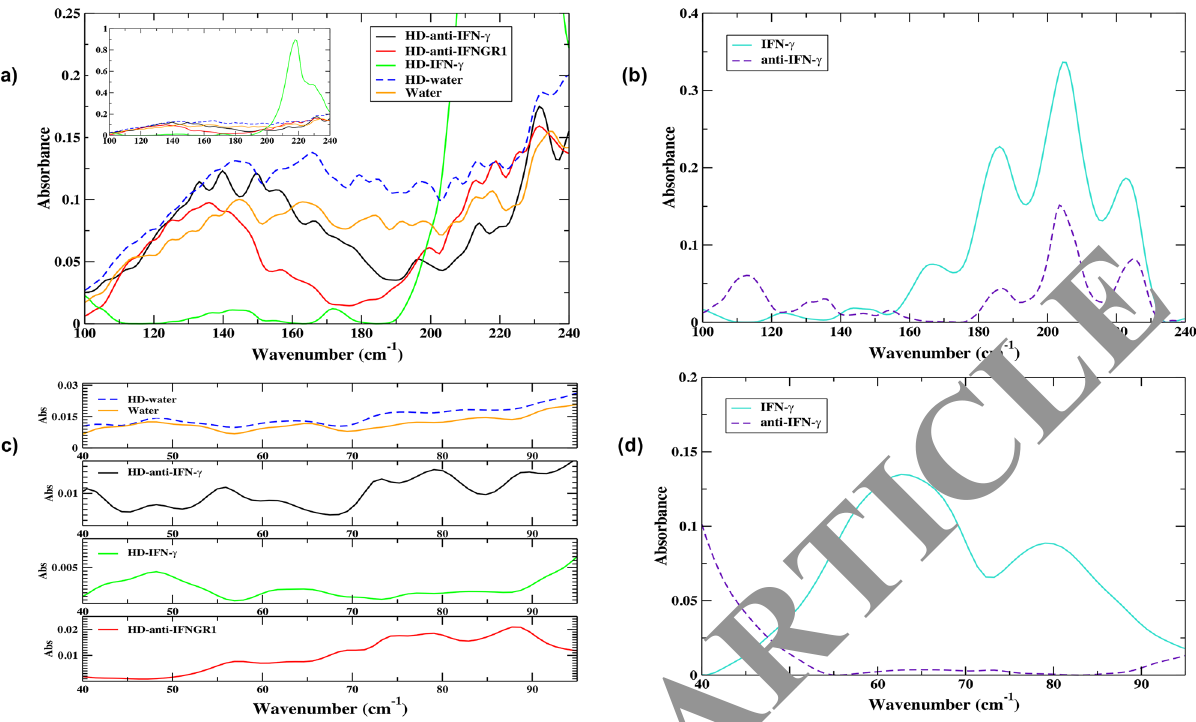
Figure 1. ( a ) Experimental THz spectrum of water (orange), HD-water (blue, dashed line), HD of antibody to IFN - γ (black), HD of antibody to IFNGR1 (red) and HD of IFN - γ (green) in the 100–240 cm − 1 spectral region. The inset shows the full amplitude of the HD-IFN - γ sample in the spectral region highlighting a prominent 217 cm − 1 mode in the spectrum. ( b ) Experimental THz spectrum of IFN - γ (cyan) and anti-IFN - γ (purple dashed line) in the 100–240 cm − 1 spectral region. ( c ) Experimental THz spectrum of water (orange), HD-water (blue, dashed line), HD of antibody to IFN - γ (black ), HD of IFN - γ (green), and HD of antibody to IFNGR1 (red) in the 40–100 cm − 1 spectral region. ( d ) The experimental THz spectrum of IFN - γ (cyan) and anti-IFN - γ (purple dashed line) in the 40–100 cm − 1 spectral